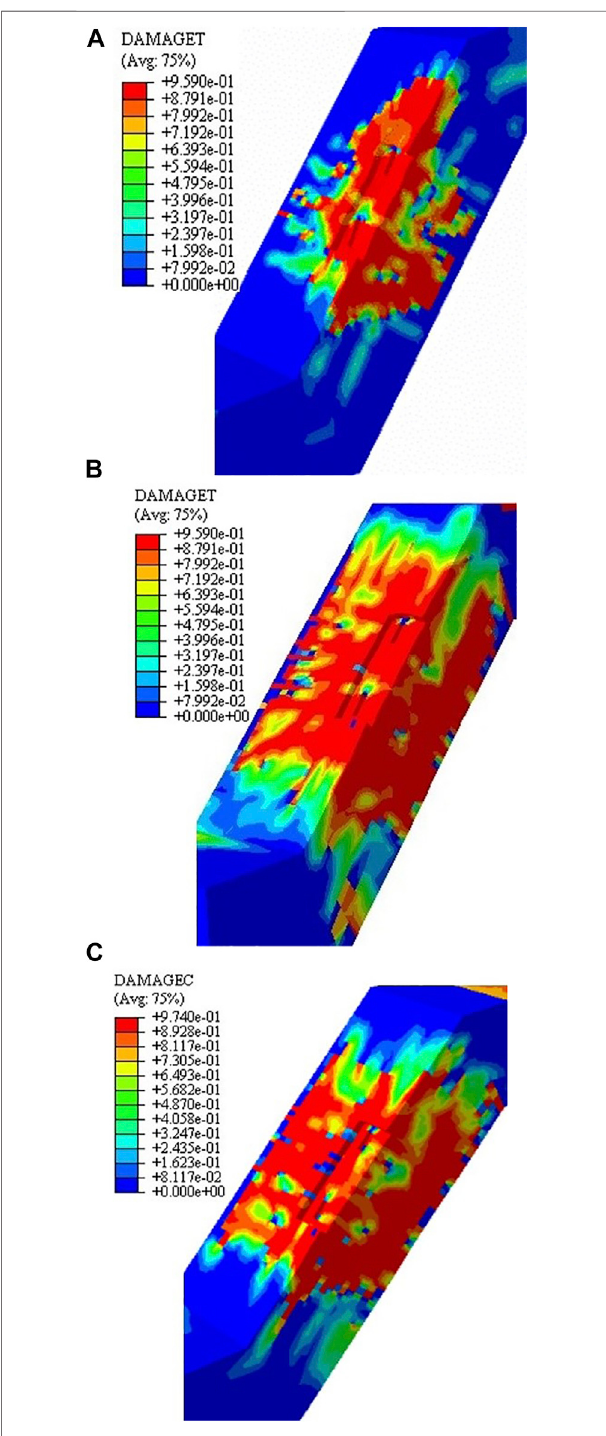
FIGURE 18 | Numerical damage distribution with different tension directions: (A) C30-000 concrete component, (B) C30-450 concrete component, (C) C30-900 concrete